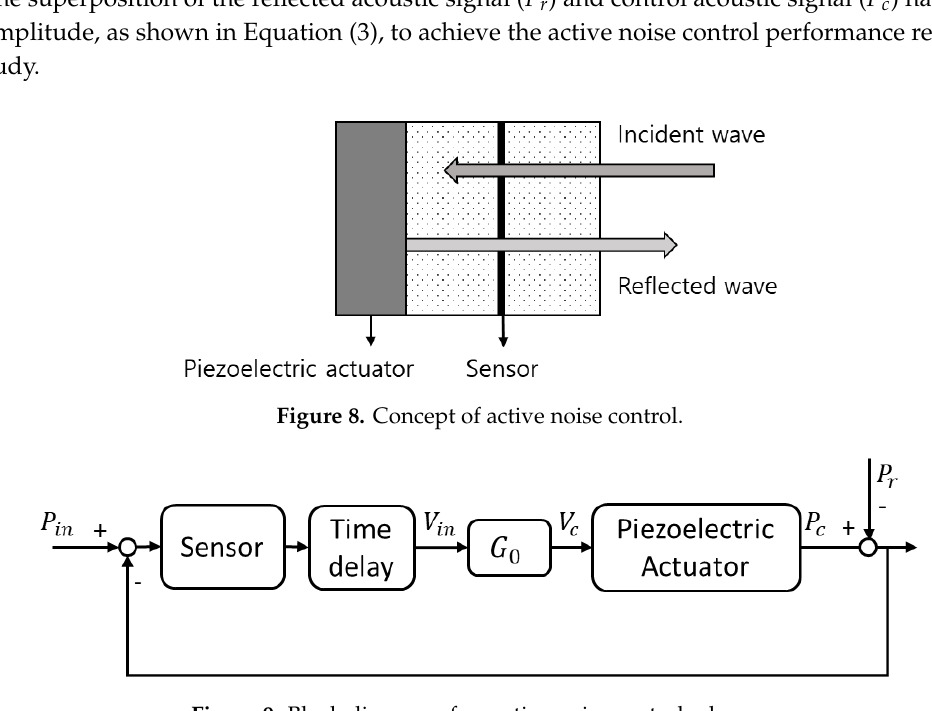
Figure 9. Block diagram of an active noise control scheme.